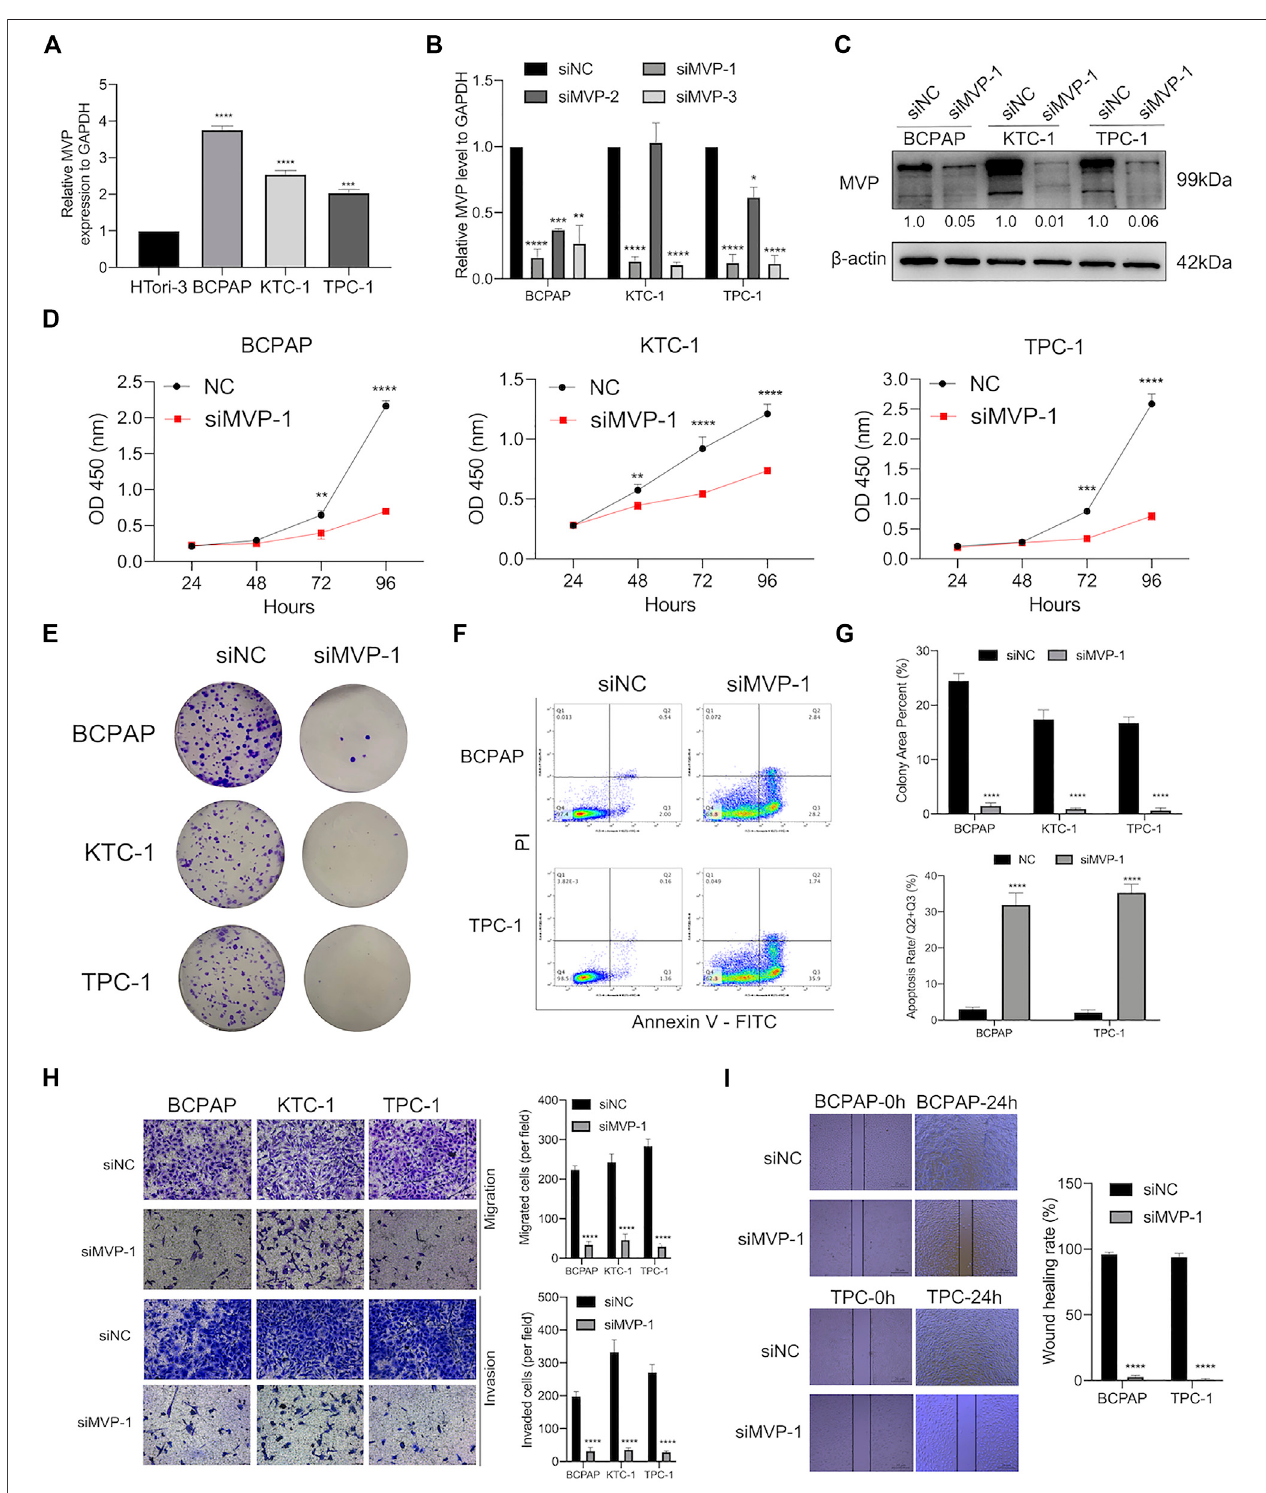
FIGURE 8 | MVP was over-expressed in PTC cell lines, promoting the capability of proliferation, colony, migration, and invasion but attenuated apoptosis in vitro . (A) Relativetranscriptlevelof MVP wassubstantiallyhigherinPTCcelllines(BCPAP,TPC-1,andKTC-1)thanthatinnormalHTori-3cellline. (B) Transcriptlevelsof MVP insi-NC,siMVP-1,siMVP-2,andsiMVP-3groupsweredeterminedbyqRT-PCR. (C) ProteinlevelsofMVPinsi-NCandsiMVP-1PTCcellsweredeterminedbyWestern blotting. (D) Cell proliferative capacity was detected through CCK-8 assays. (E) Clonogenic ability was determined through Colony formation assays. (F) Cell